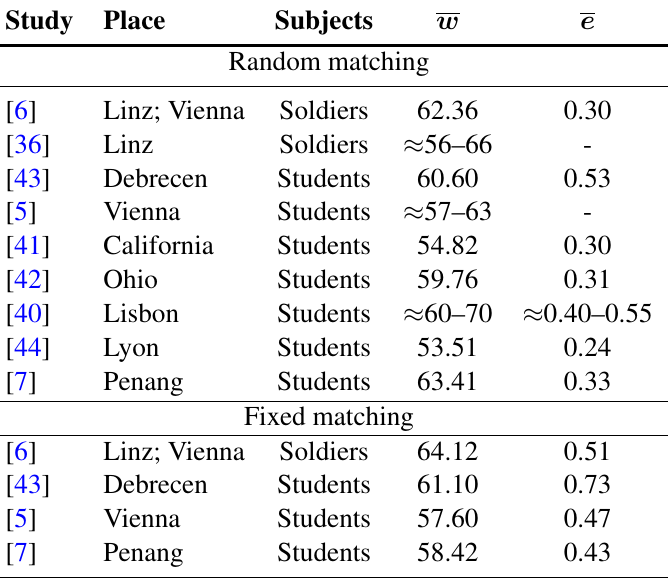
Table 5. Performance in comparable previous bilateral gift-exchange game